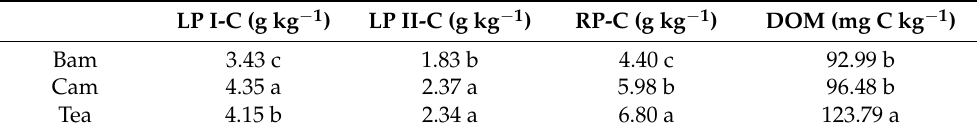
Table 3. Labile and recalcitrant pools of soil organic carbon, and soil dissolved organic matter in bamboo (Bam), camphor (Cam), and tea (Tea) plantations.